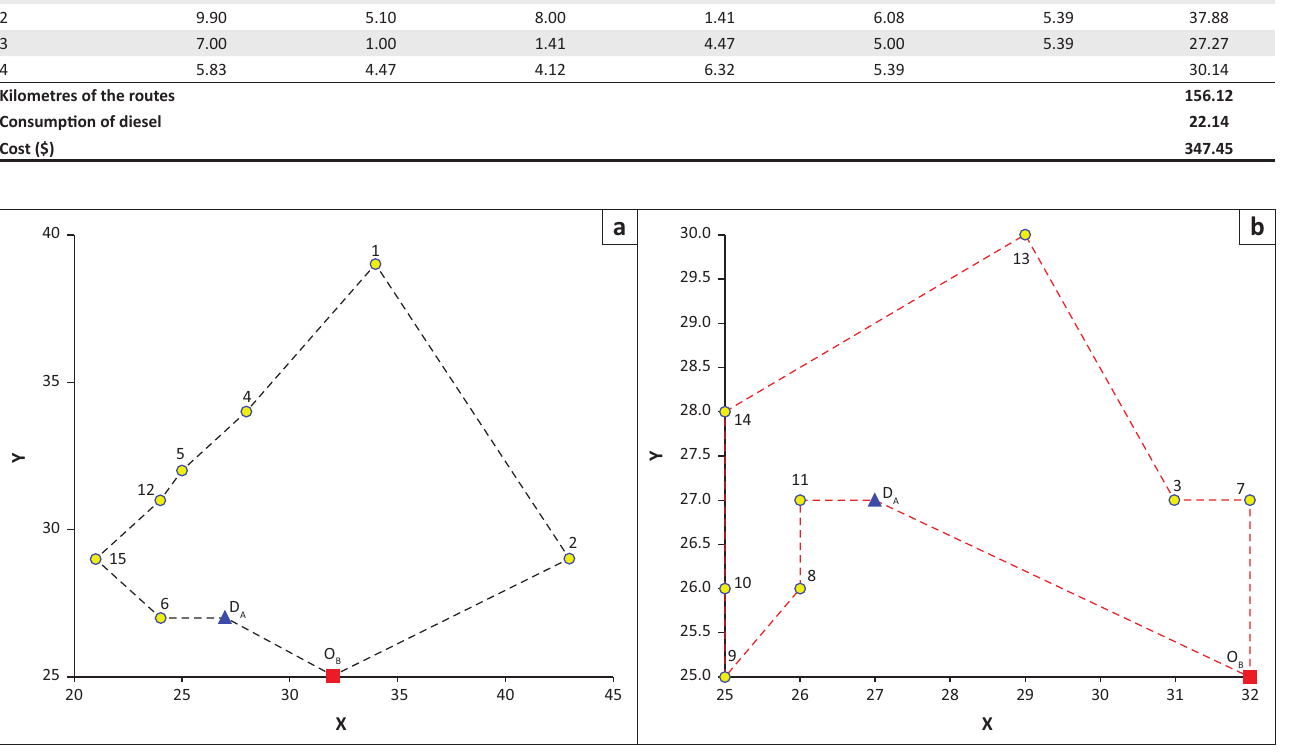
FIGURE 7: Optimised routes served by company B as determined by the Capacitated Vehicle Routing Problem for Carriers model for the real problem: (a) Route 1 and (b) Route 2. TABLE 5: Optimised distance (kilometres) and fuel consumption per route for the real problem.